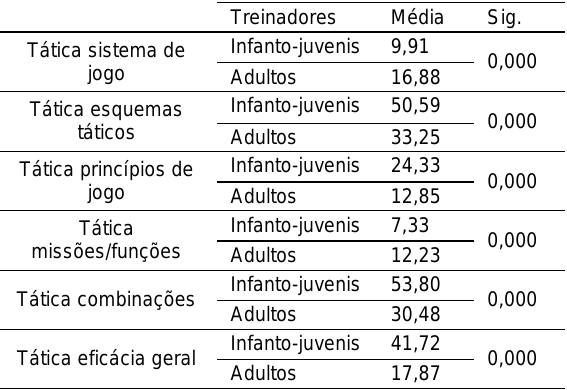
Tabela 3. Comparação na dimensão conteúdo (tático) da instrução durante a